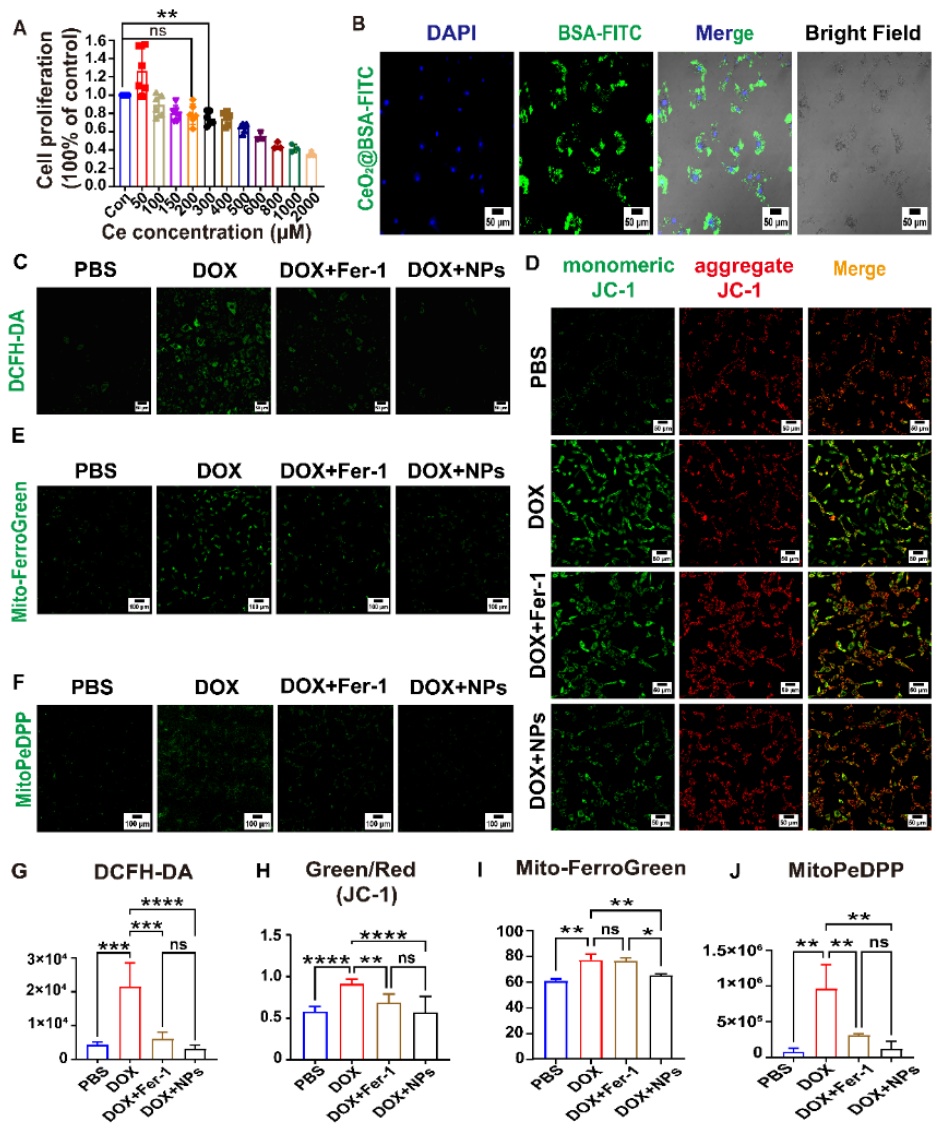
Figure 4. CeO 2 @BSA NPs protect against DIC by preventing ferroptosis in H9c2 cell lines. ( A ) MTT cell viability experiment of the different concentrations of CeO 2 @BSA NPs measured by cerium concentration on H9c2 cells at 24 h. ( B ) Representative confocal microscopy images of the cellular uptake of CeO 2 @BSA NPs at 6hrs, scale bar = 100 µ m. ( C ) Fluorescent images of H9c2 cells that were stained with DCFH-DA, scale bar = 50 µ m. ( D ) Representative confocal microscopy images of H9c2 cells that were stained with JC-1 dye, scale bar = 50 µ m. ( E ) Representative fluorescent images of H9c2 cells’ mitochondrial ferrous ions that were stained with Mito-FerroGreen, scale bar = 100 µ m. ( F ) Representative fluorescent images of H9c2 cells’ mitochondrial lipid peroxides that were stained with MitoPeDPP, scale bar = 100 µ m. ( G ) Quantification of ROS via DCFH-DA intensity in ( C ). ( H ) Quantification of MMP of H9c2 cells via JC-1 monomer/JC-1 aggregates in ( D ). ( I ) Quantification of ferrous ions in mitochondria measured by Mito-FerroGreen intensity in ( E ). ( J ) Quantification of mitochondrial lipid peroxides by MitoPeDPP intensity in ( F ). DAPI: 4 (cid:48) ,6 (cid:48) - diamidino-2-phenylindole, FITC: fluorescein isothiocyanate, DOX: doxorubicin, Fer-1: ferrostatin-1, NPs: CeO 2 @BSA nanoparticles, PBS: phosphate buffer solution, H 2 O 2 : hydrogen peroxide; DCFH- DA: 2 (cid:48) ,7 (cid:48) -dichlorofluorescin diacetate; ROS: reactive oxygen species; MMP: mitochondrial membrane potential. Data are expressed as mean ± SEM of three to five independent replicates; * p < 0.05, ** p < 0.01, *** p < 0.001, **** p < 0.001, ns: no statistical